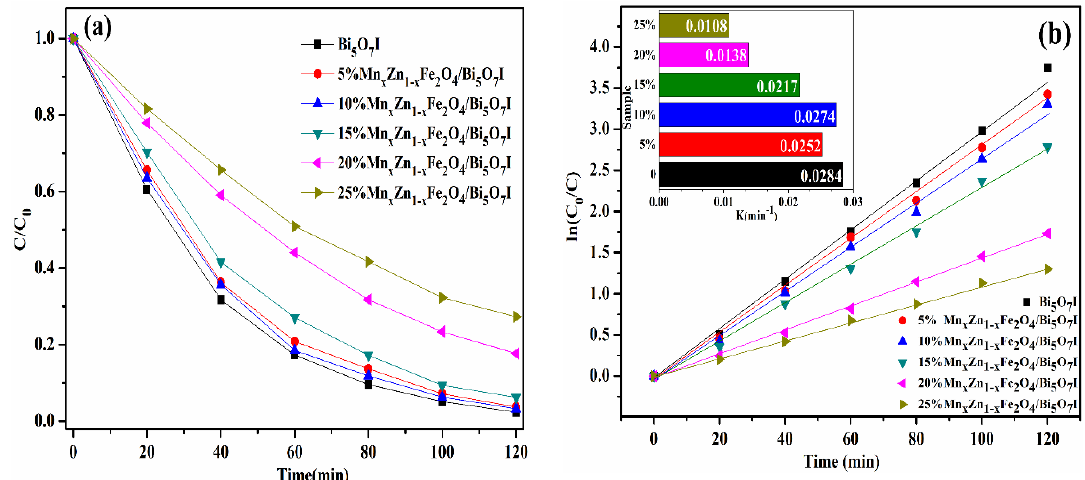
Figure 9. ( a ) Photocatalytic degradation and ( b ) kinetic linear simulation curves of Rhodamine B (RhB) over Bi 5 O 7 I and Bi 5 O 7 I/Mn x Zn 1 − x Fe 2 O 4 .